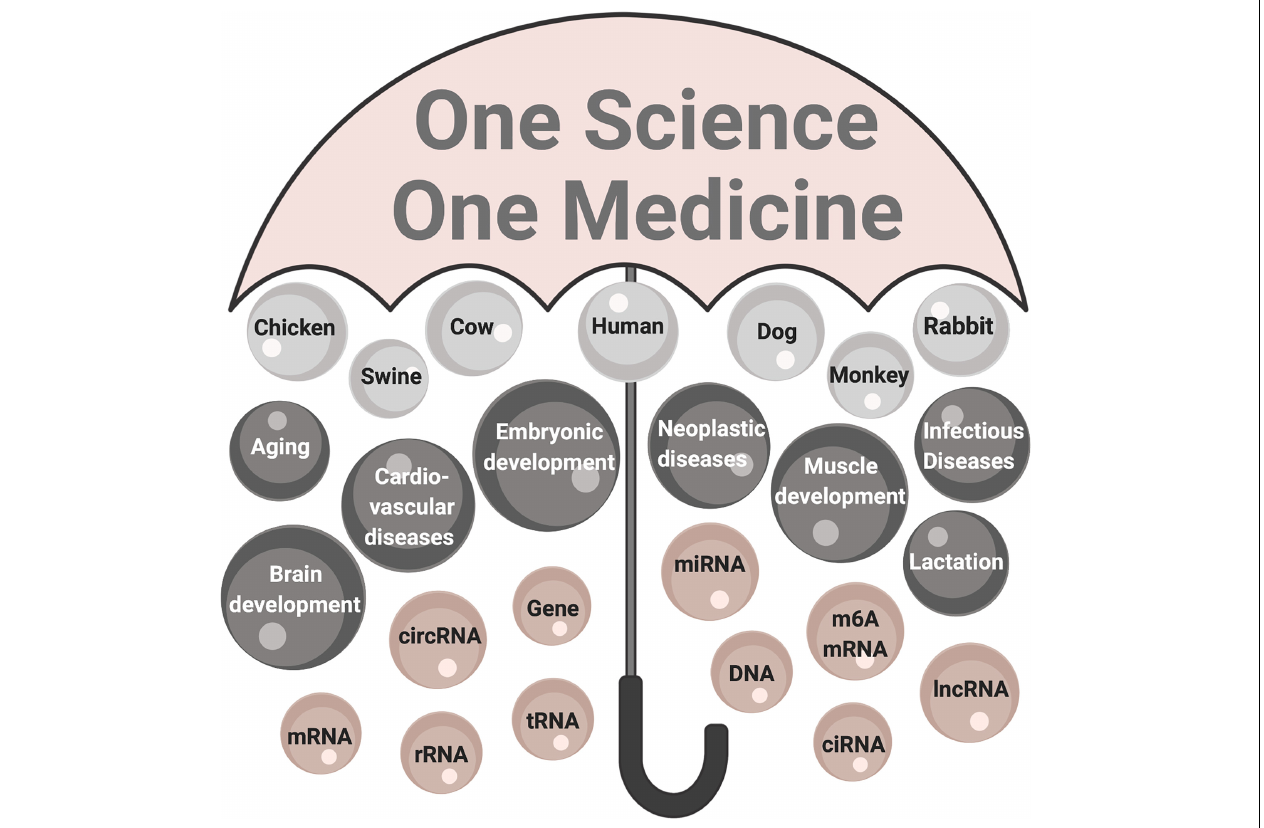
FIGURE 3 | The One Health perspective of circRNA research. The umbrella labeled One Science One Medicine encompasses circRNA research in human and animal species that is contextual to healthy people, animals, environments. The significance of circRNA research: organisms are top-level components (light gray); processes and conditions affected are mid-level components (dark gray); and fundamental components are molecules (mauve). mRNA, messenger RNA; circRNA, circularized RNA; rRNA, ribosomal RNA; tRNA, transfer RNA; miR, microRNA, m 6 A mRNA, mRNA modified by adenine modification; ciRNA, circularized intronic RNA; lncRNA, long non-coding